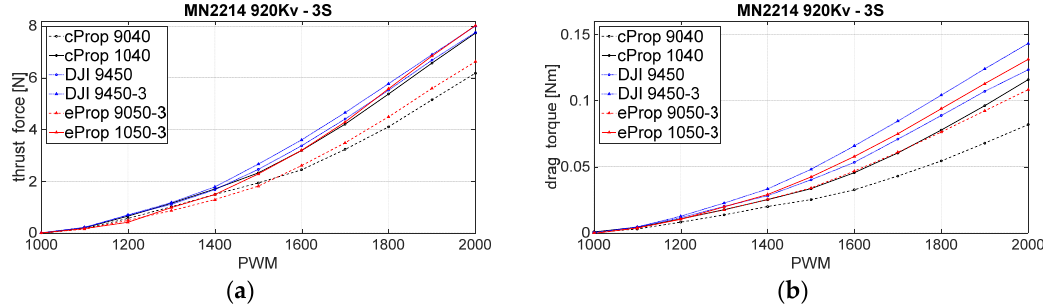
Figure 11. Static maps—MN 2214 BLDC motor: ( a ) thrust force; ( b ) drag torque.